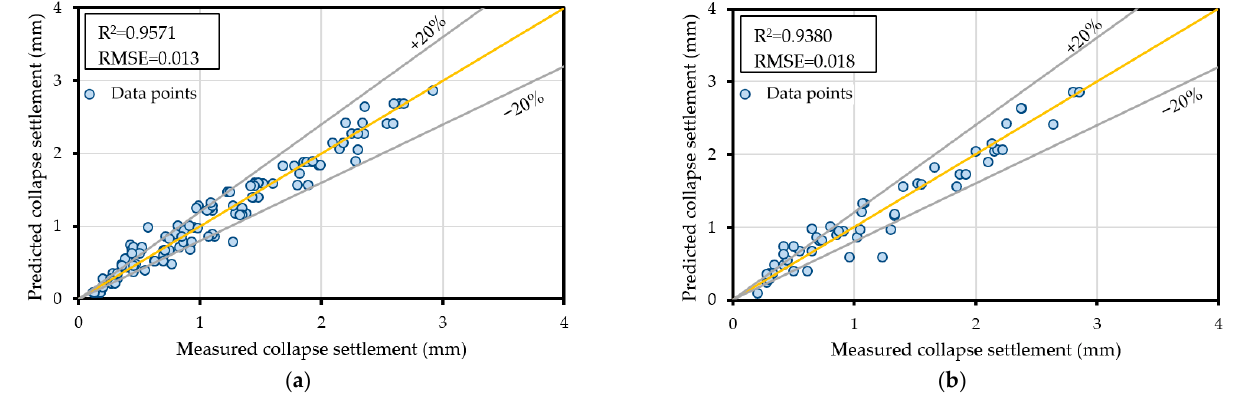
Figure 8. Comparing the results of the predicted and measured collapse settlement based on the sinusoidal function. ( a ) Training data, ( b ) Testing data.